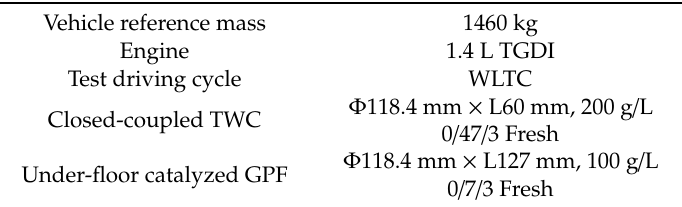
Figure 2. Tests of the particulate number filtration and e ffi ciency. Table 3. Main parameters of the test